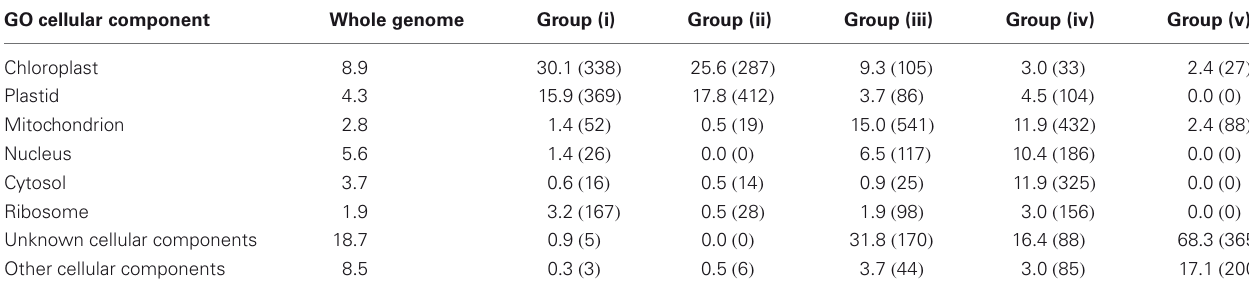
Table 2 | GO analysis of the genes co-expressed with the different groups of MTERFs